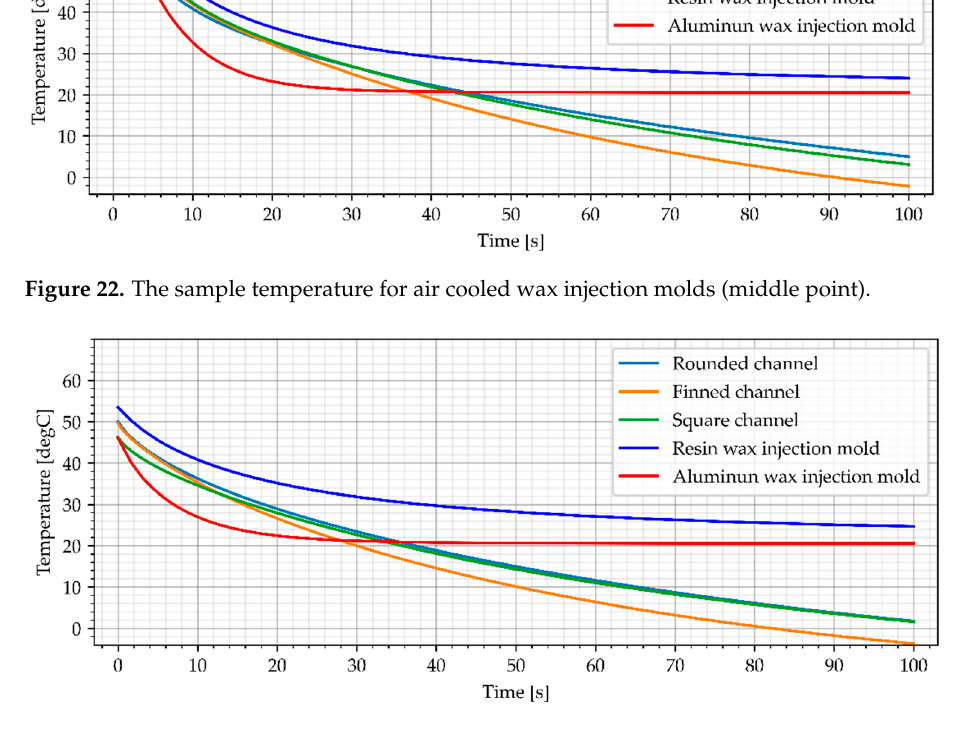
Figure 23. The average temperature of the sample.